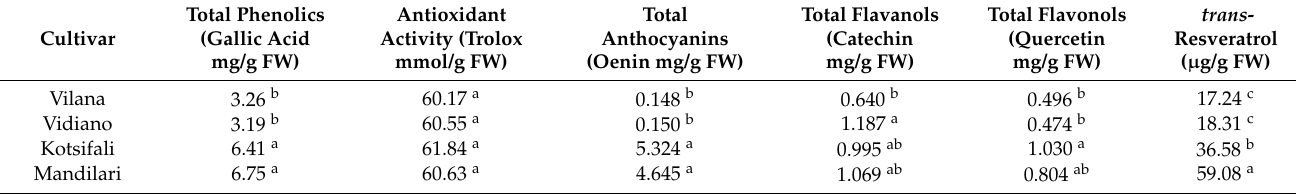
Different letters indicate statistically significant differences among cultivars, according to Duncan’s multiple range test ( p ≤